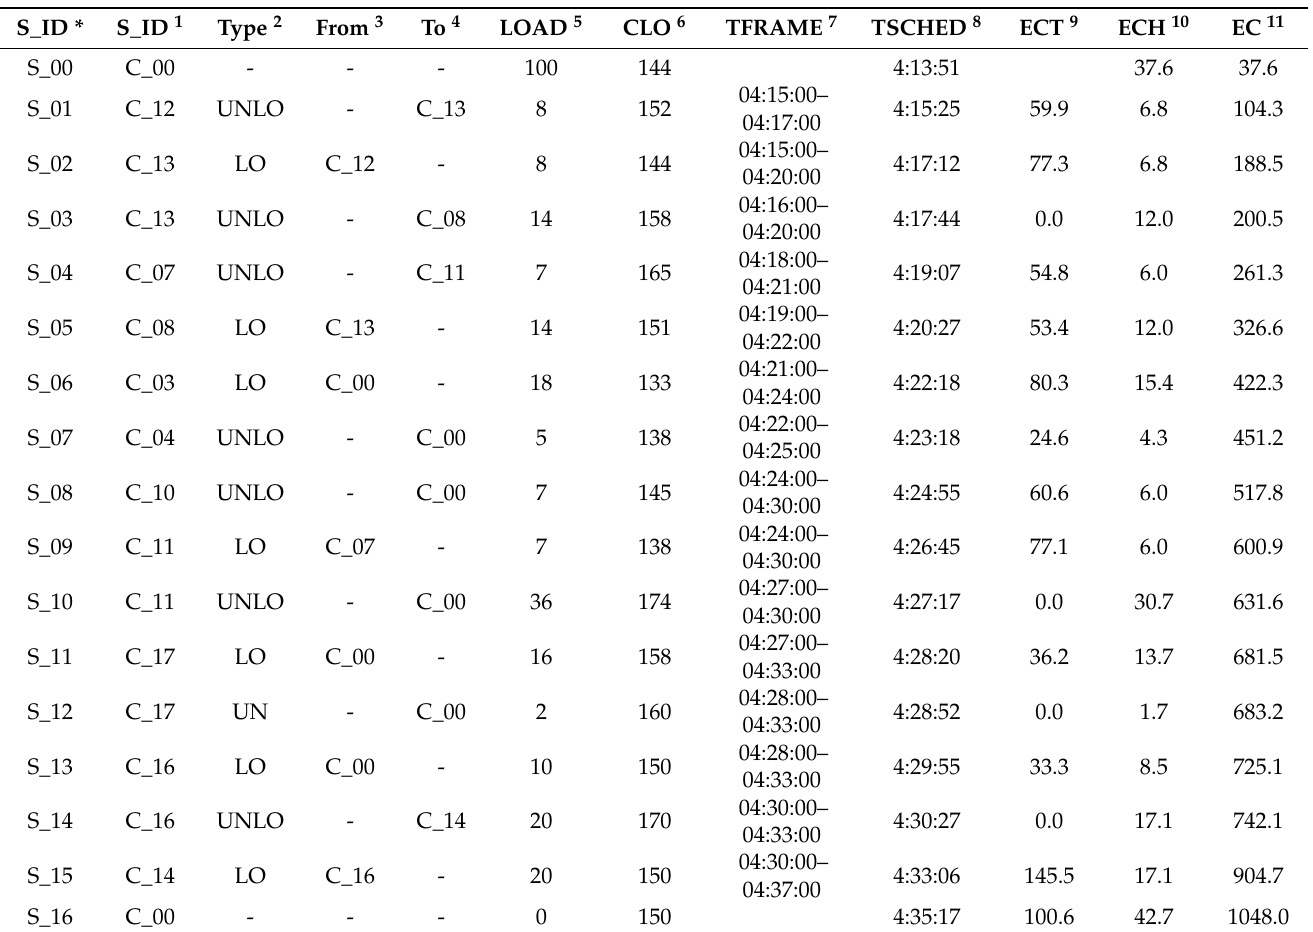
Table 5. Numerical results of the scheduling of predefined specific in-plant material supply operations performed by the milk-run trolley within route